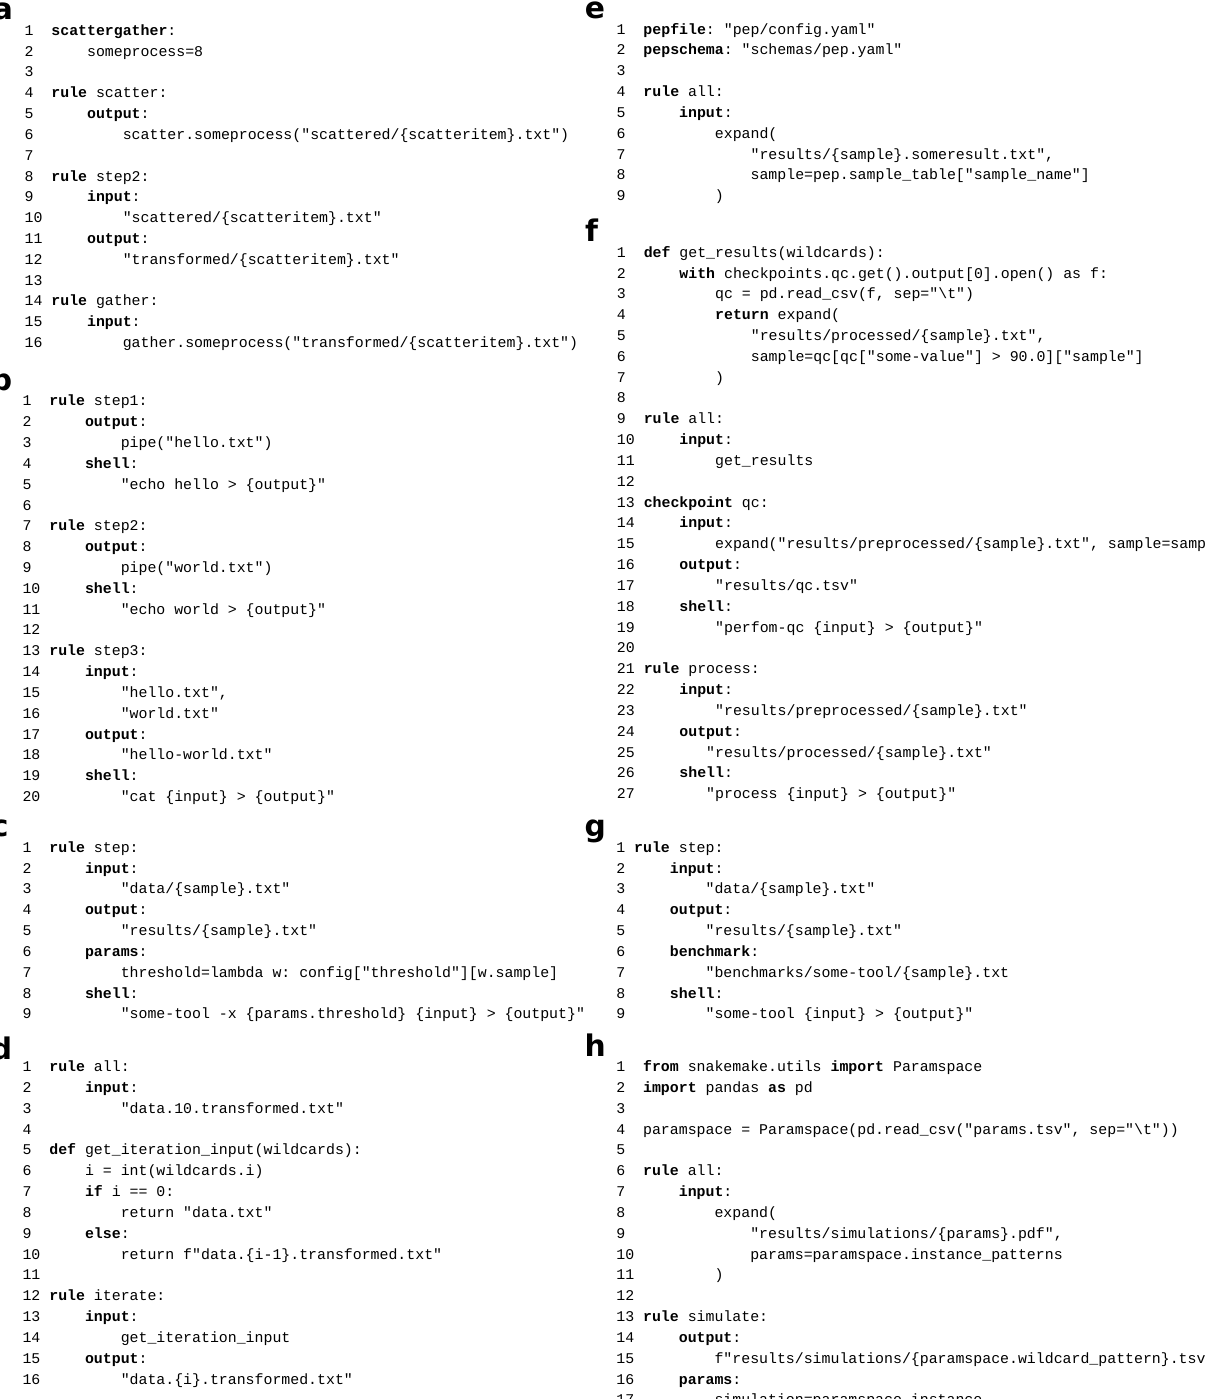
Figure 8. Additional design patterns for Snakemake workflows. For brevity only rule properties that are necessary to understand each example are shown (e.g. omitting log directives and shell commands or script directives). ( a ) scatter/gather process, ( b ) streaming, ( c ) non-file parameters, ( d ) iteration, ( e ) sample sheet based configuration, ( f ) conditional execution, ( g ) benchmarking, ( h ) parameter space exploration. See subsection 3.2 for